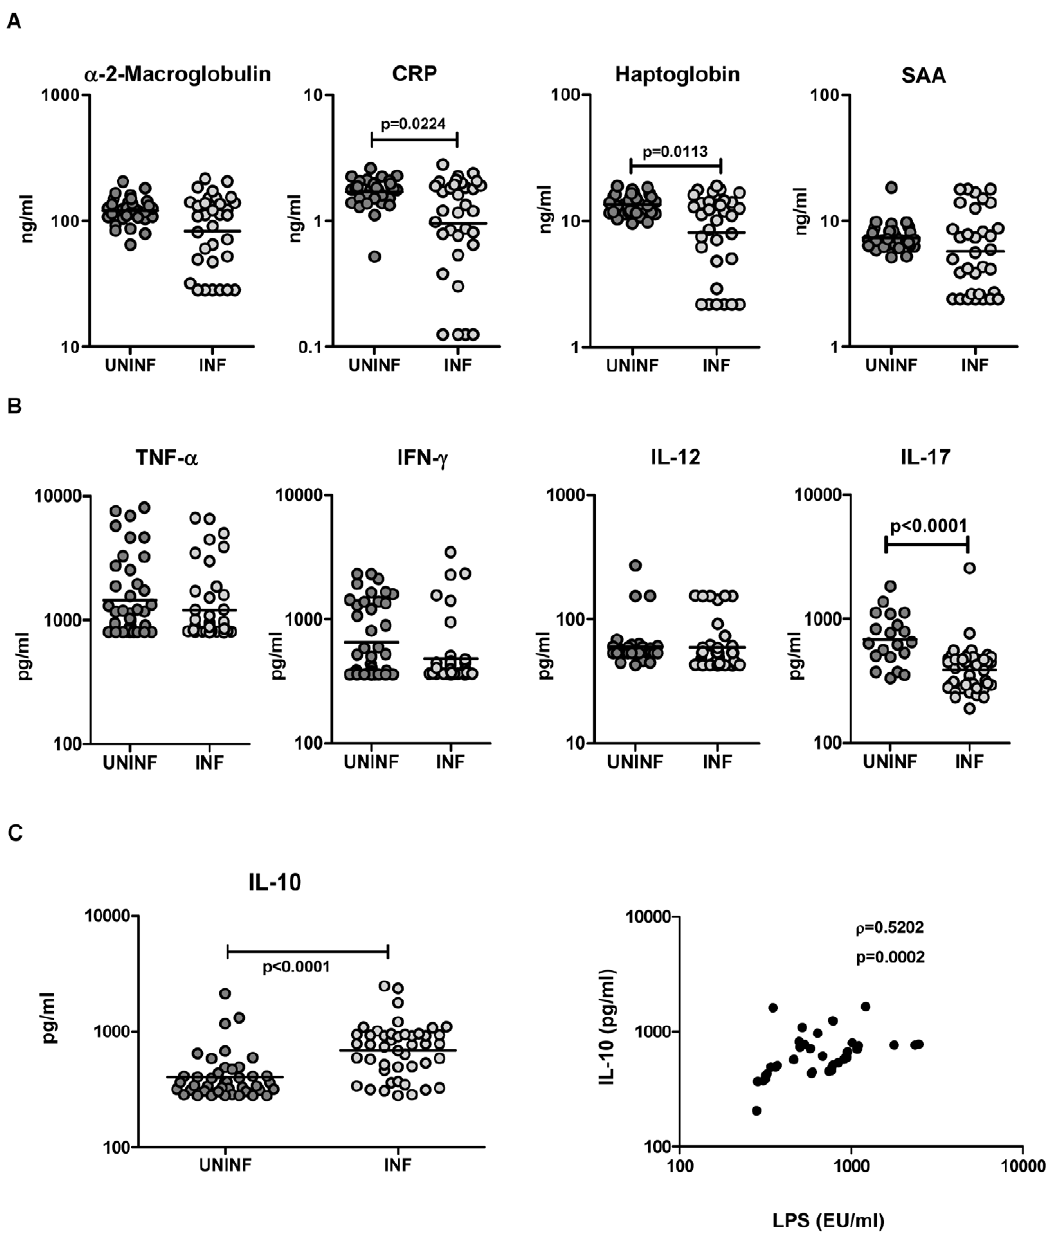
Figure 2. Hookworm infection is not associated with elevated levels of acute-phase proteins or pro-inflammatory cytokines. A , Plasma levels of a -2 macroglobulin, C-reactive protein (CRP), haptoglobin, and serum amyloid proteins (SAA) from hookworm-infected [INF] (n=33) or uninfected [UNINF] (n=33) individuals were measured by ELISA. B , Plasma levels of TNF- a , IFN- c , IL-12, and IL-17 from INF (n=45) or UNINF (n=20–42) individuals were measured by ELISA. (C) Plasma levels of IL-10 from INF (n=45) and UNINF (n=42) individuals were measured by ELISA. Plasma levels of LPS were correlated with levels of IL-10 in INF (n=45) individuals. P values were calculated using the Mann-Whitney test and Spearman rank correlation